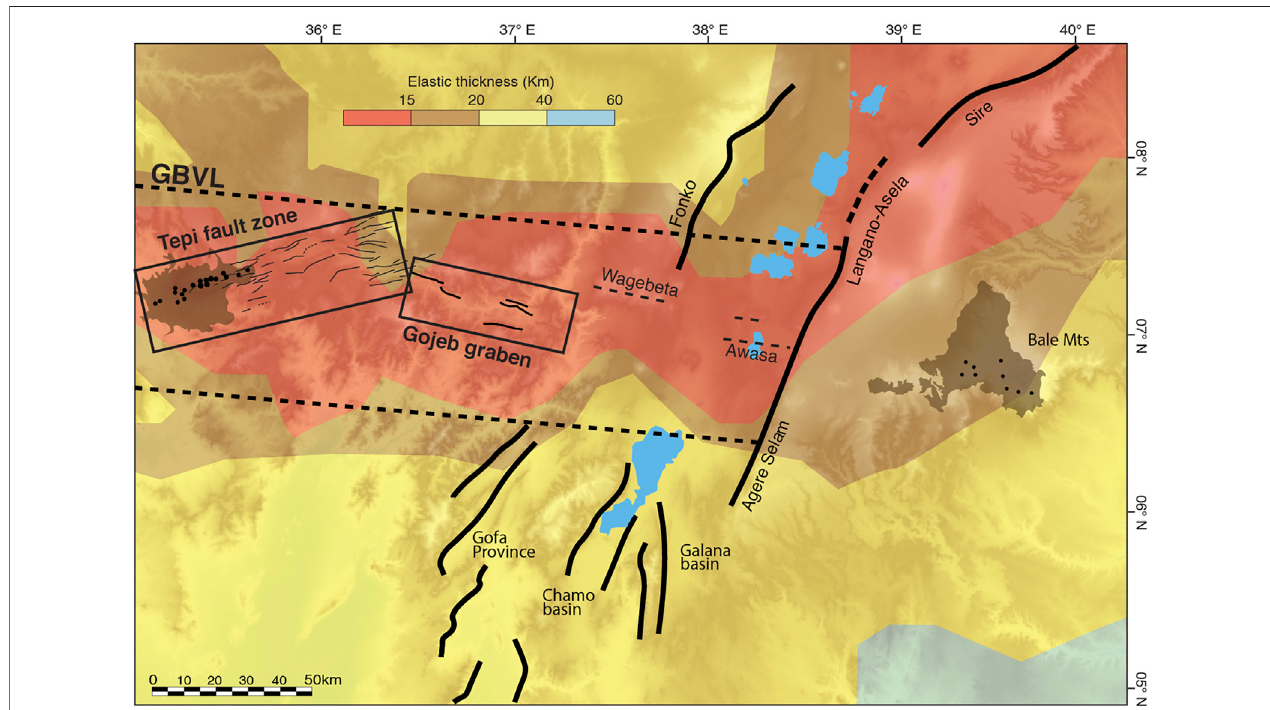
FIGURE 3 | Structural scheme of the Goba Bonga lineament (from Corti et al., 2018b) superimposed on a map of the elastic thickness of the lithosphere (Te), modi fi edafterPérez-Gussinyéetal.(2009).LowTevalues( < 10 – 15 km)areobservedinanarrowregionextendinginaroughlyE-Wdirectionintheregioncorresponding to the extent of the Goba Bonga